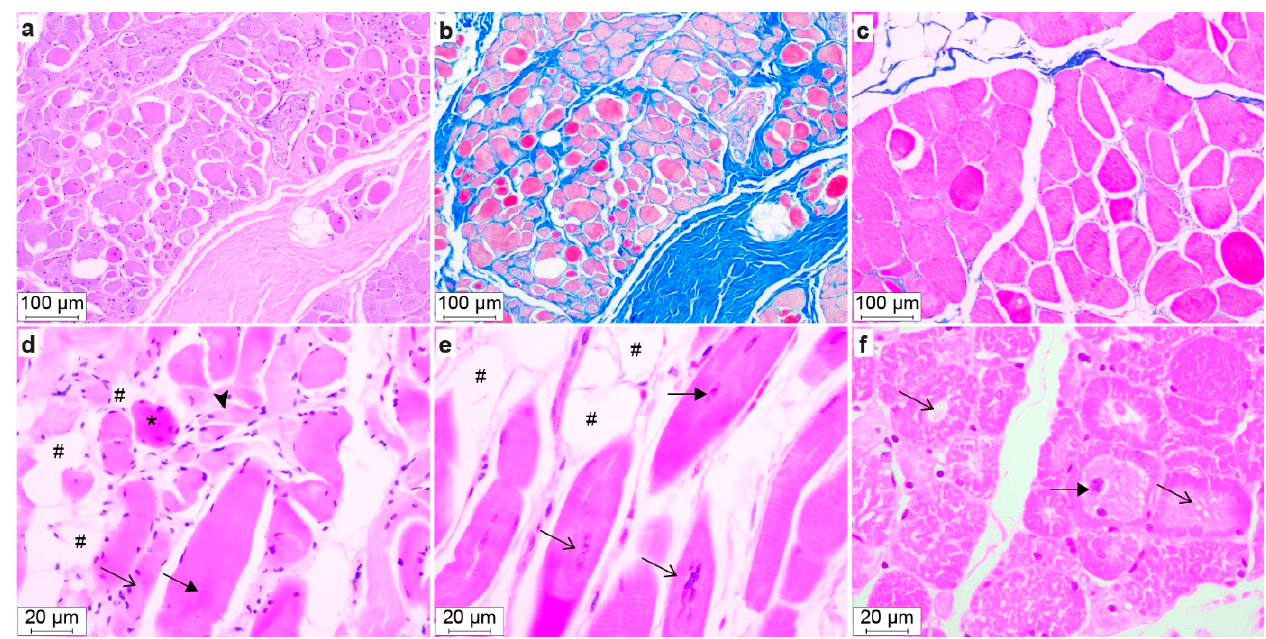
Figure 5. Histopathology of muscle sections from Dogs #2 ( a – d ), #4 ( e ), and #1 ( f ). H&E staining ( a , d – f ) and Masson trichrome staining ( b , c ). ( a , b ) m. masseter with severe endomysial and perimysial fibrosis seen as blue staining in ( b ). ( c ) m. biceps femoris with sparse blue-stained areas, i.e., no fibrosis. ( d ) m. triceps brachii showing disorganized myofibers, hypertrophic (filled arrow), normotrophic (arrow), atrophic (arrowhead), hypereosinophilic swollen myofibers (*), and lipocyte infiltrates (#). ( e ) m. triceps brachii , longitudinal section, showing centralized nuclei (filled arrow), chains of nuclei (arrow) and lipocyte infiltrates (#). ( f ) m. biceps femoris , transverse section, showing variable myocyte diameter, centralized nuclei (filled arrow) and central cytoplasmic pallor (arrow). Table 4. Myocyte diameter and evaluation of centralized nuclei, clarity, lipocyte infiltration, and fibrosis in three English springer spaniels with dyserythropoietic anemia myopathy syndrome.